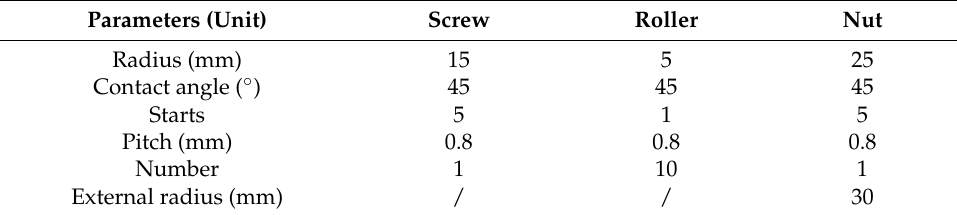
Figure 9. The mechanical behavior analysis flow of the downhole robot system. Table 2. The designed parameters of the PRSM for the downhole robot